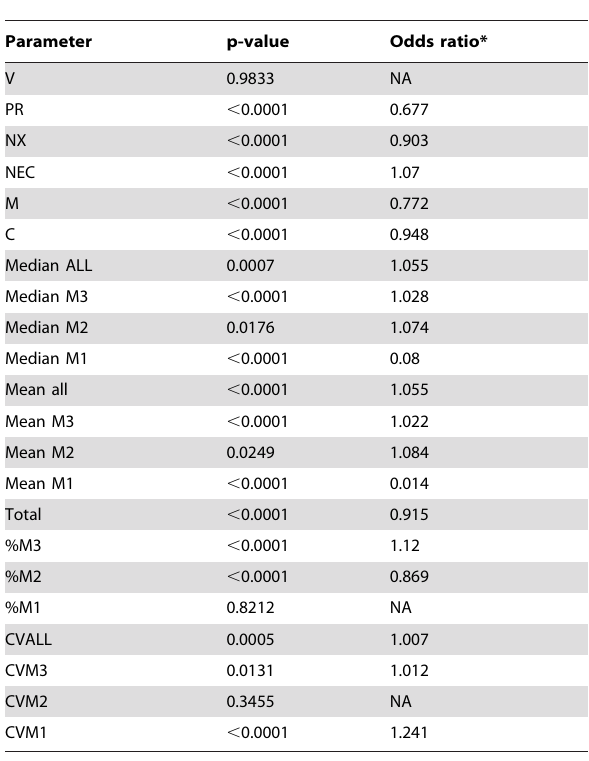
Table 2. Relationship between the clinically diagnosed male infertility and individual, conventional and flow cytometric SPTRX3 parameters reflective of sperm